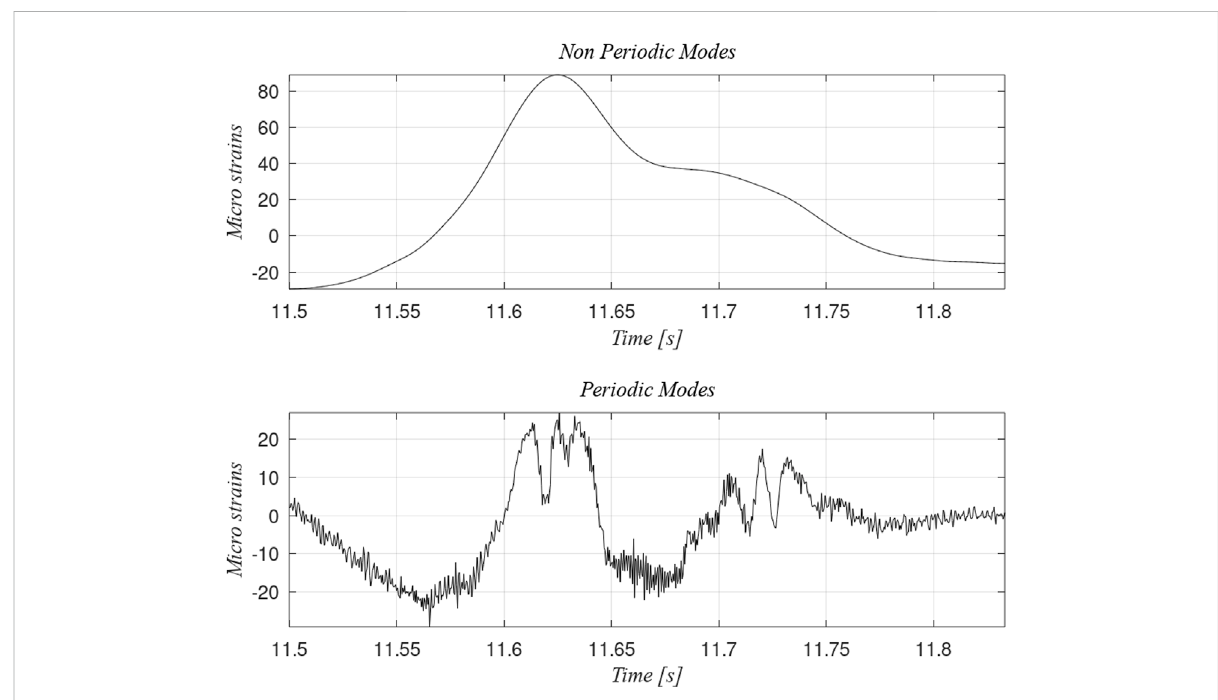
FIGURE 3 Comparison of the non-periodic and periodic intrinsic modes for the strain measured at the experimental rig.